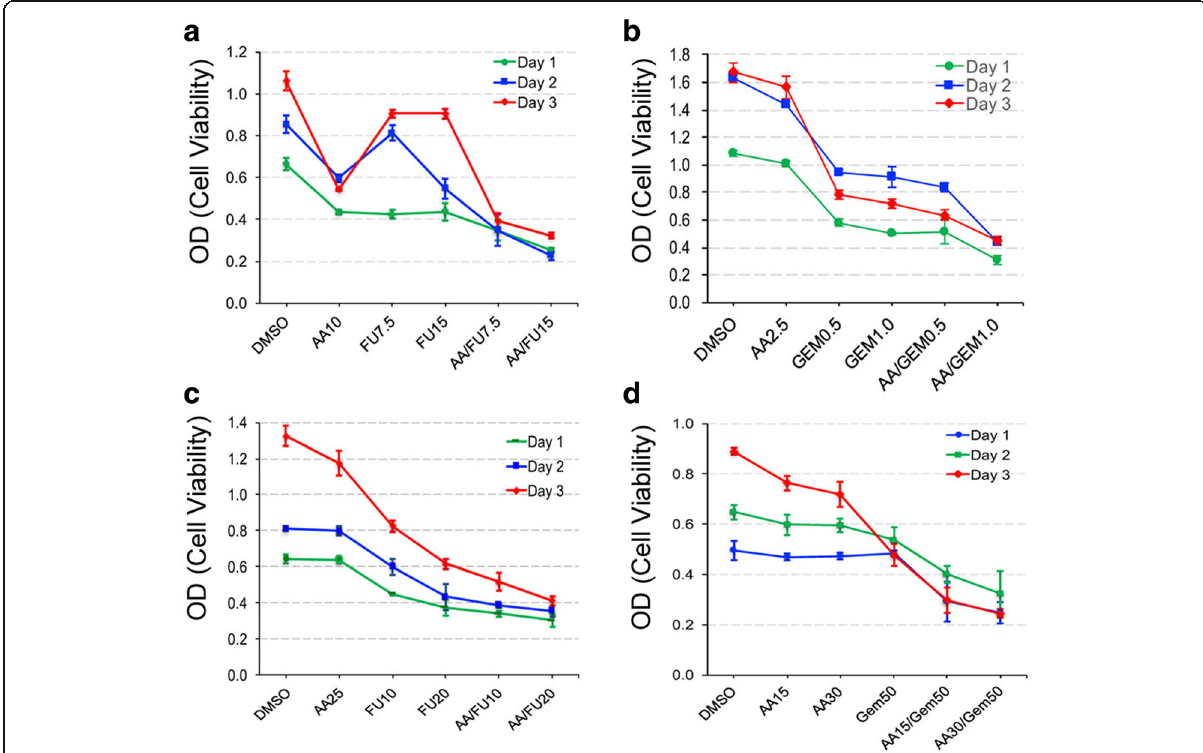
Fig. 2 AA increased the cytotoxic effect of 5-FU and GEM. The MTT cell viability data is obtained from BXPC-3 ( a and b ) and PANC-1 ( c and d ) cells, respectively. Label on the X-axis indicates treatment with various concentration of AA, 5-FU (FU) or GEM alone or in combination of AA and 5-FU or GEM in nM or DMSO as control. Data was analyzed from three samples at 24, 48 and 72 h after initial treatment. Error bars represent standard deviation